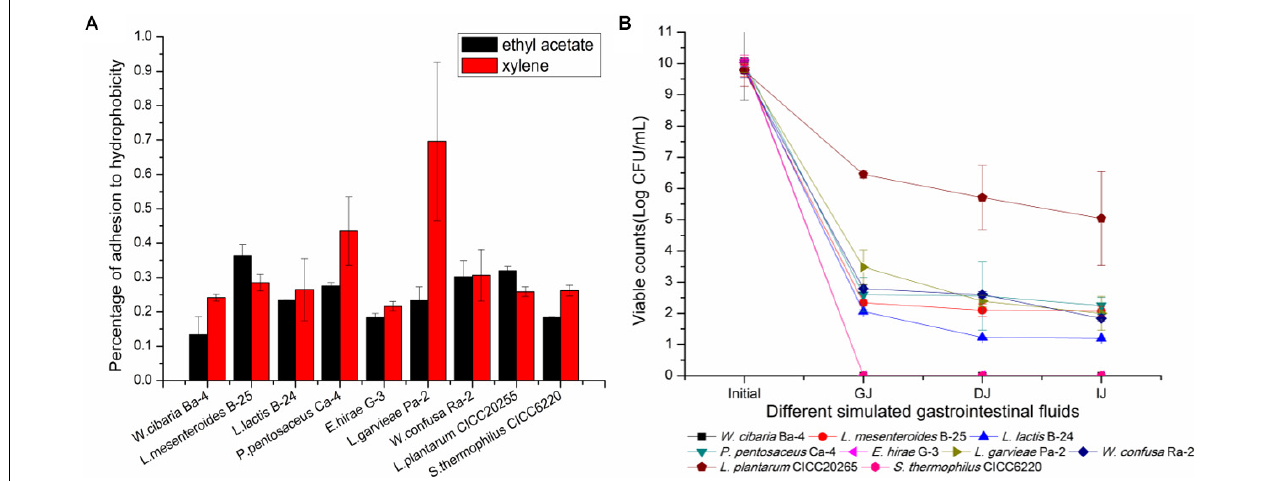
FIGURE 6 | Evaluation of hydrophobicity to ethyl acetate and xylene and survival of simulated gastrointestinal digestion of the nine selected LAB strains. (A) Percentage of hydrophobicity. (B) Survival capacity of LAB strains during simulated gastrointestinal digestion. GJ, gastric juice; DJ, duodenal juice; IJ, intestinal